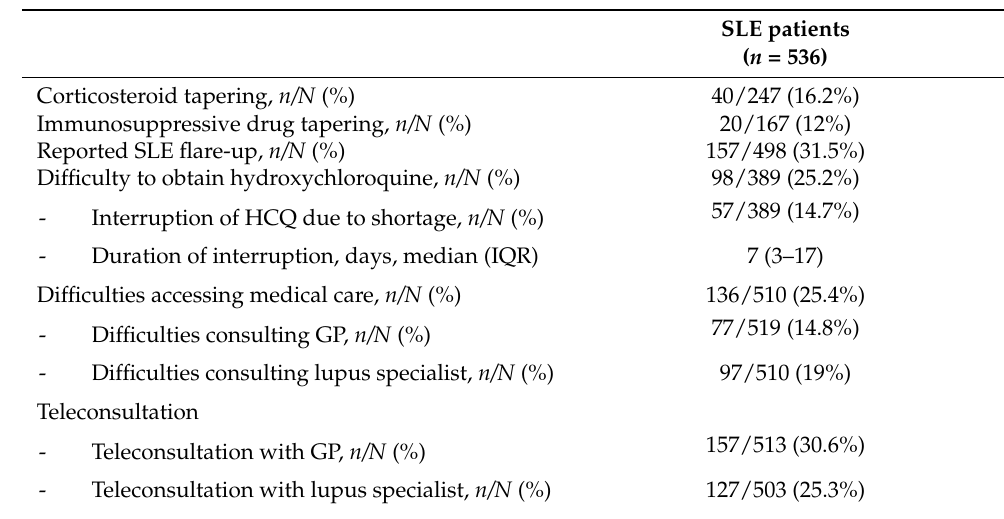
Table 2. Difficulties reported during the early COVID-19 pandemic. Abbreviation: GP, general practitioner; SLE, systemic lupus erythematosus.